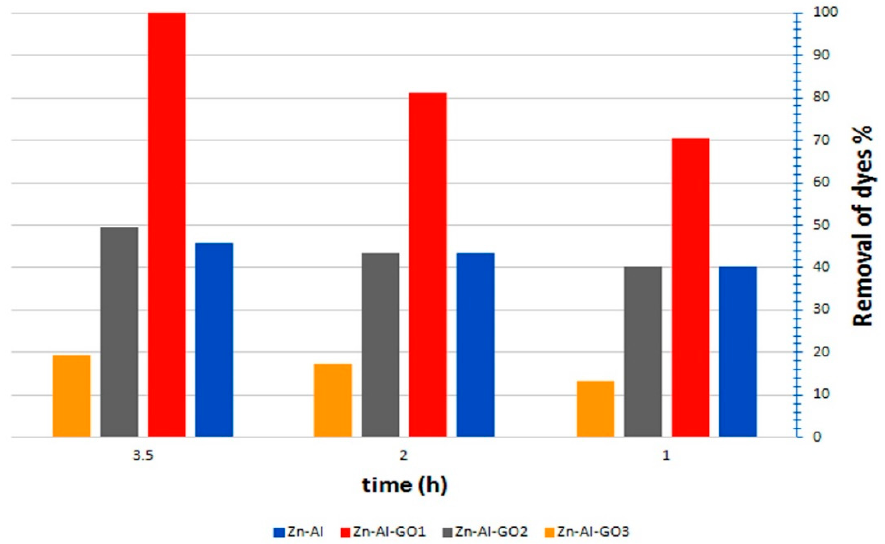
Figure 14. Photocatalytic activity of Zn-Al LDHs before and after doping with graphene oxide at different times.